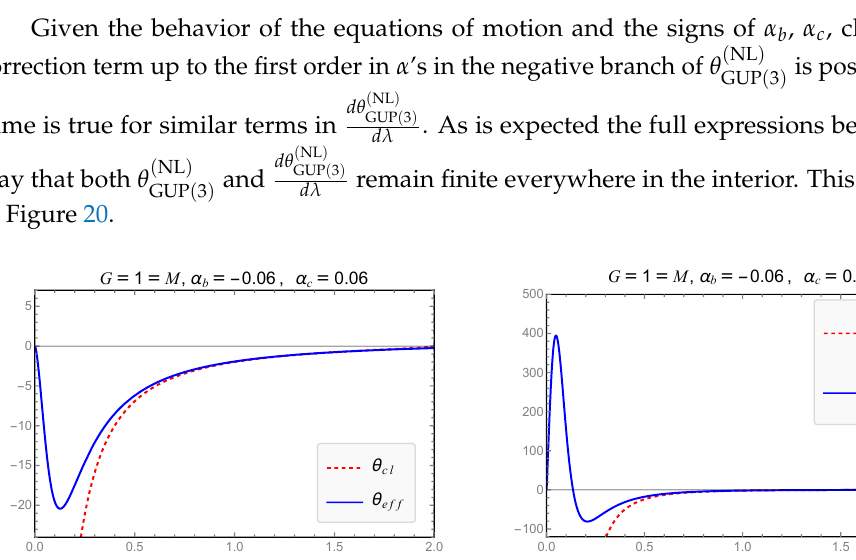
in GUP model 3 as a function of the d τ